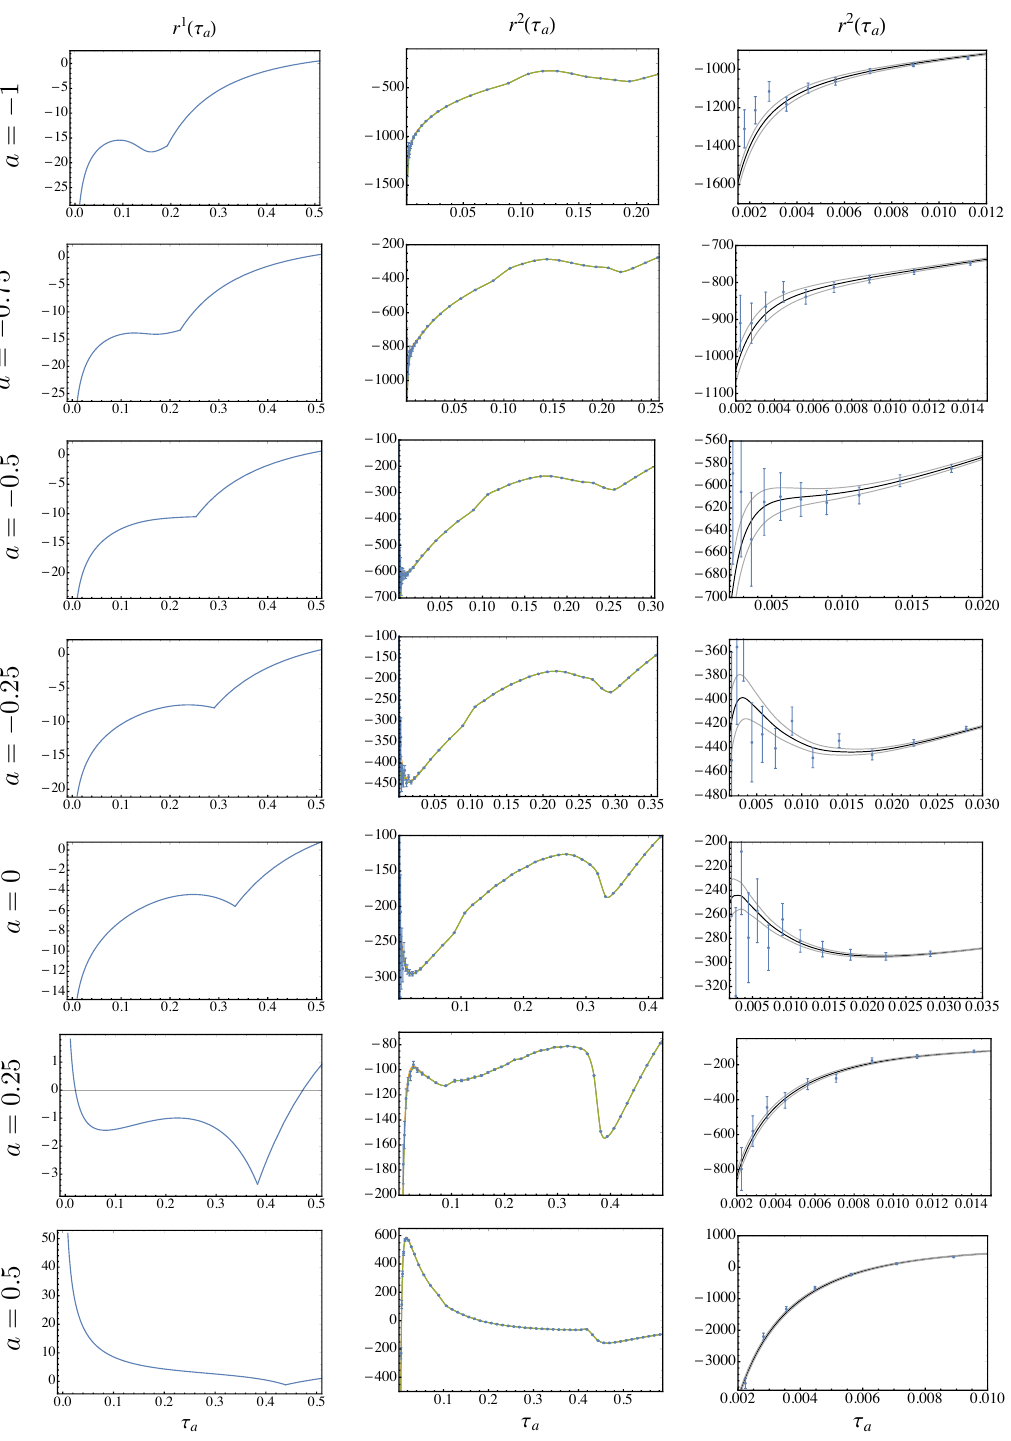
Figure 8 . Left : ( (cid:11) s ) remainder functions from [34]. Middle : O the whole physical spectrum. Right : magni(cid:12)ed plots of the latter in the low (cid:28) a region. Note that the vertical scales di(cid:11)er signi(cid:12)cantly across the plots, a(cid:11)ecting the visual appearance of the uncertainty bands’ actual widths.